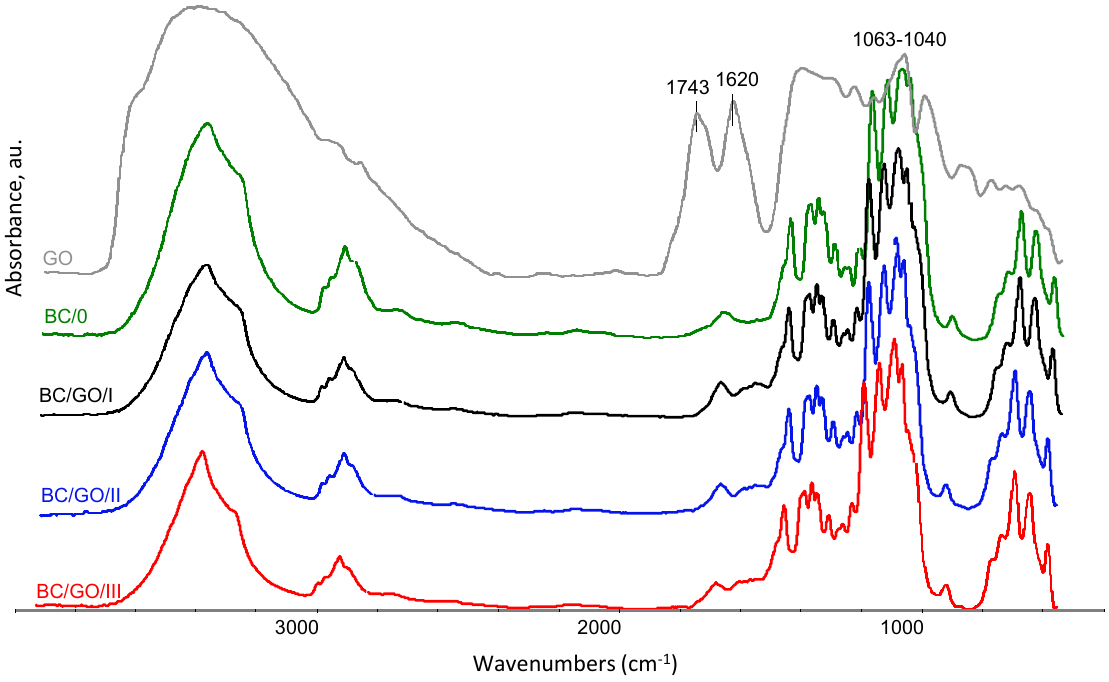
Figure 10. Summary of FTIR spectra for the following samples: pure BC (BC/0), BC/GO/I, BC/GO/II and BC/GO/III composite membranes and GO. The spectra were recorded in the range of 4000 ÷ 400 cm − 1 .